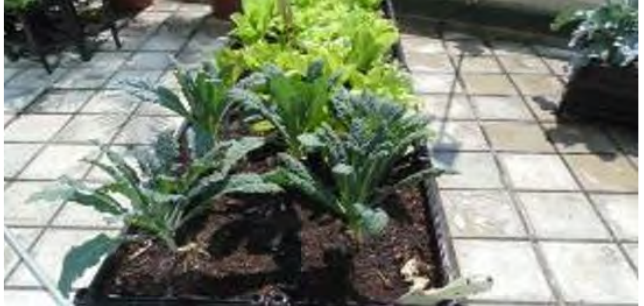
Figure 5. Hong Kong weather is ideal for vegetables cultivation throughout the year. (Containers roof agriculture method, 2017)